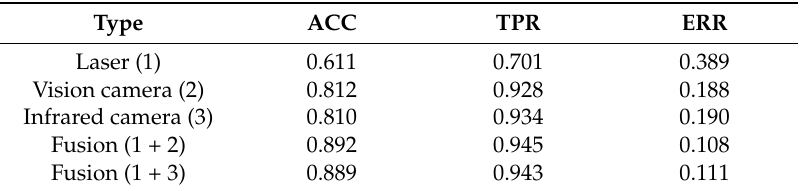
Table 2. Results for different sensor